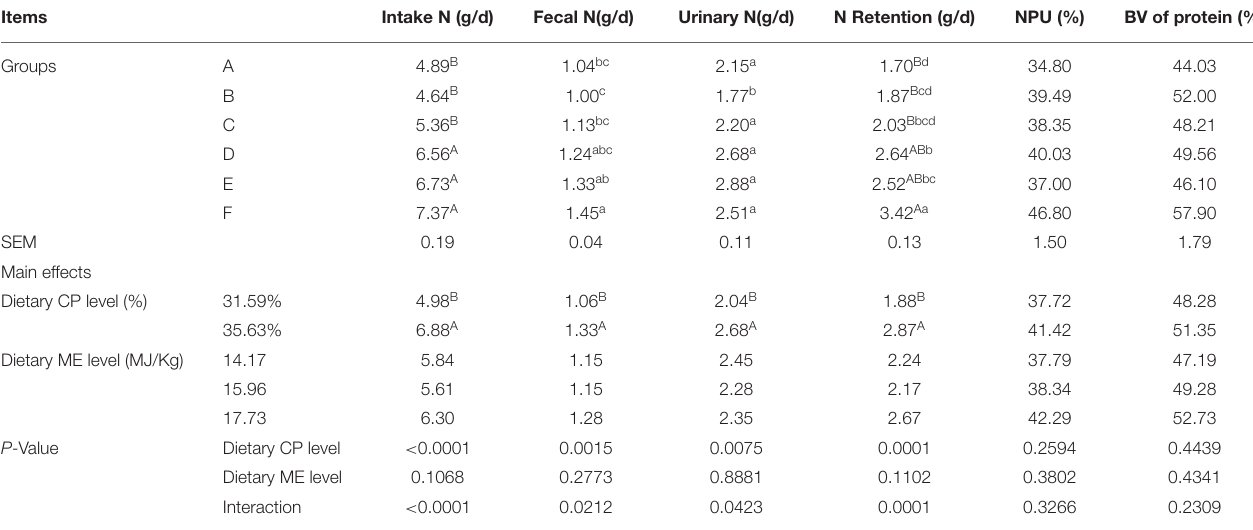
TABLE 5 | Effects of energy and protein levels on nitrogen balance of mink during growing period.